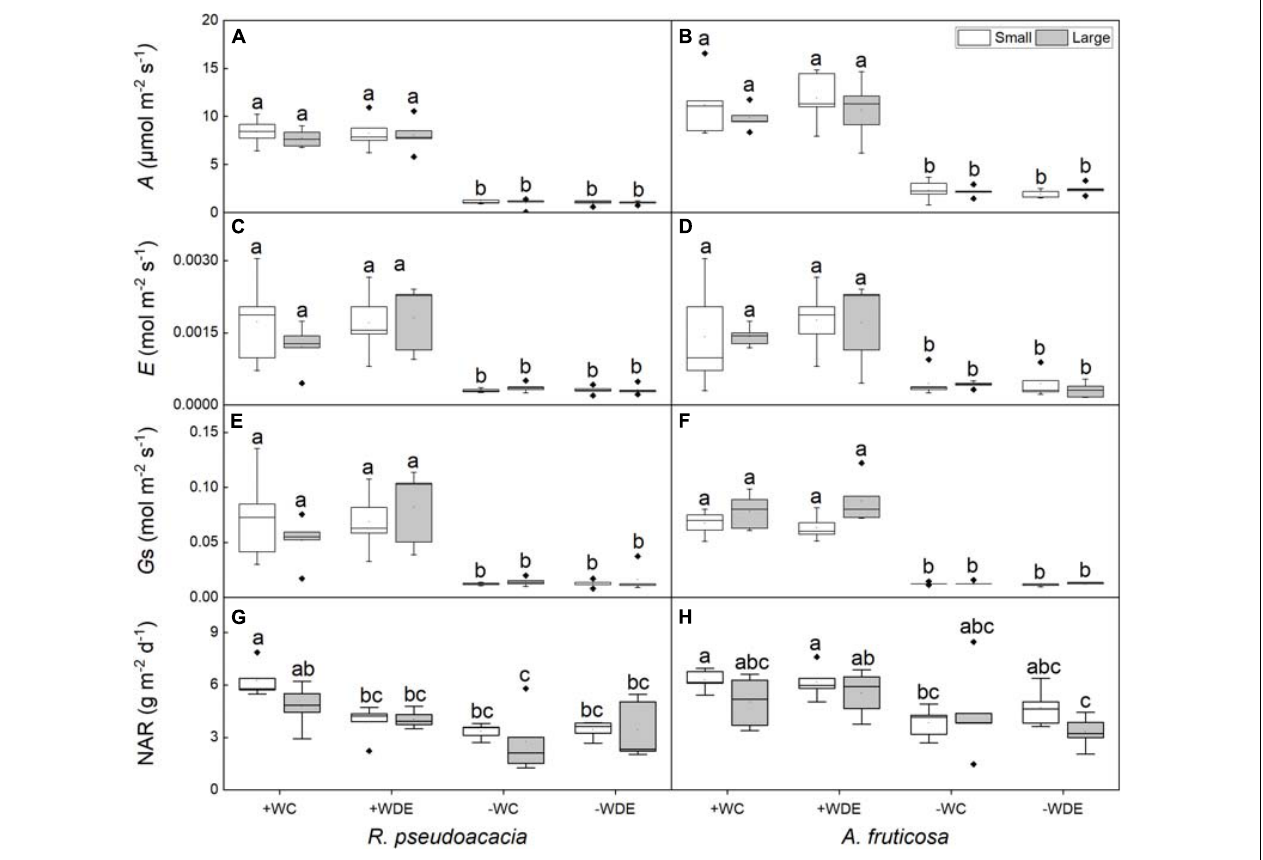
FIGURE 3 | Seedling gas exchange parameters of Robinia pseudoacacia (A,C,E,G) and Amorpha fruticosa (B,D,F,H) under various water availability and defoliation treatments for 60 days of two plants sizes. The values of the boxplot are the mean of five replicates. Different letters indicate significant differences among different defoliation and water treatments according to Duncan’s test ( p < 0.05). +WC, high water availability without defoliation; +WDE, high water availability treatment with defoliation; –WC, low water availability without defoliation; –WDE, low water availability with defoliation, A , the net photosynthetic rate; E , transpiration rate; G s , stomatal conductance; NAR, net assimilation